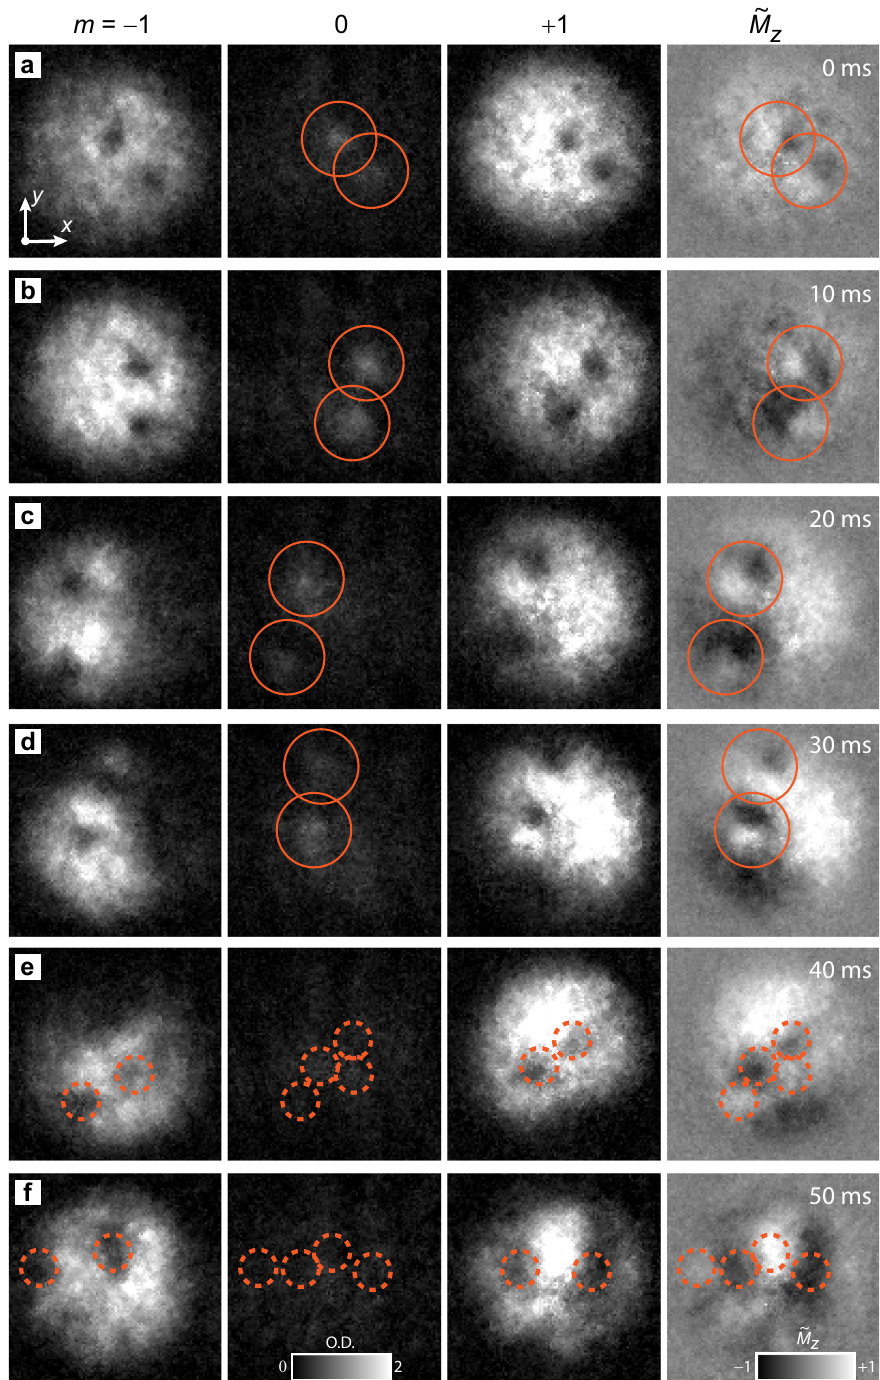
Fig. 4 Time evolution of the singly-quantized vortices after a radiofrequency π /2-pulse. a – f Images of the spinor-component column densities ~ n m for m = − 1, m = 0, and m = − 1, and the longitudinal magnetization column density ~ M realization of the experiment with an evolution time of (0, 10, 20, 30, 40, 50) ms after the pulse, respectively. Solid orange circles in ( a – d ) indicate identi fi able maxima in the m = 0 spinor component and are overlaid upon the magnetization image. Dashed orange circles in ( e , f ) are estimated locations of offset phase singularities identi fi ed from circumscribed density minima in the m = ±1 spinor components and are similarly overlaid on the m = 0 and magnetization images. All densities are integrated along the imaging ( z ) axis and expressed in units of optical depth (O.D., grayscale bars). The fi eld of view of each image is 219 μ m × 219 μ